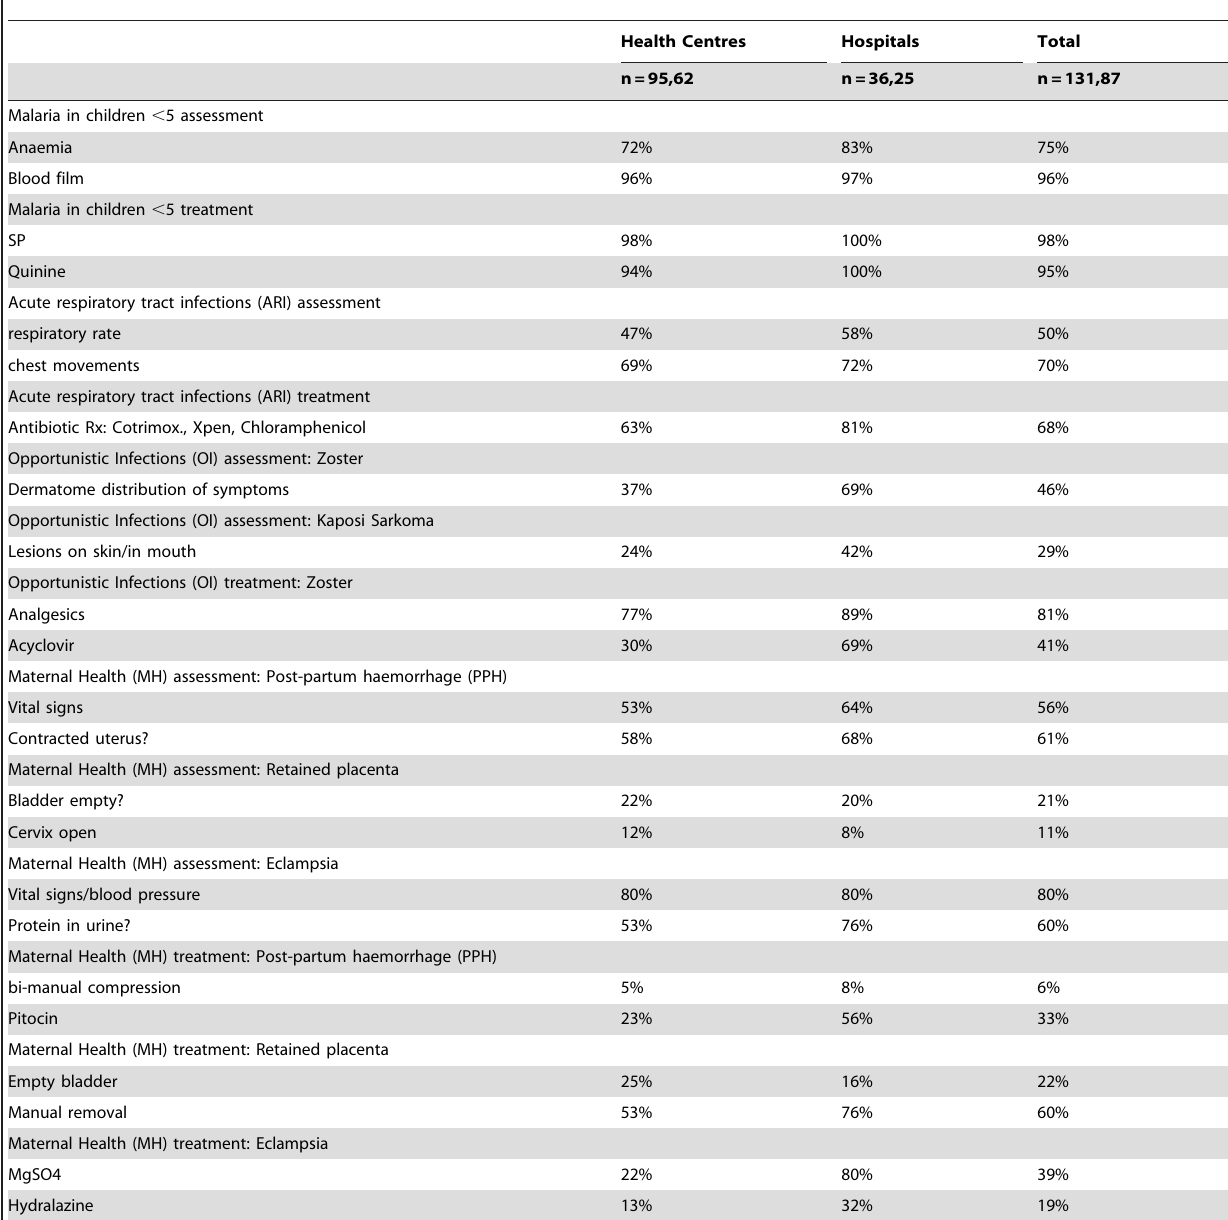
Table 5. Percentage of health workers that mention selected key aspects for assessment and treatment of malaria, ARI, OI and obstetric complications (by hc/hospitals), n= total number of respondents, number of respondents to obstetric questions (with obstetric